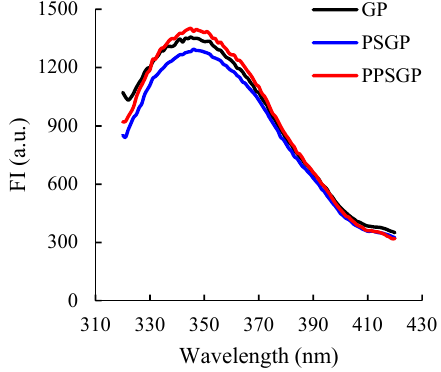
Figure 3. Fluorescence spectroscopy of GP isolate for intrinsic fluorescence.